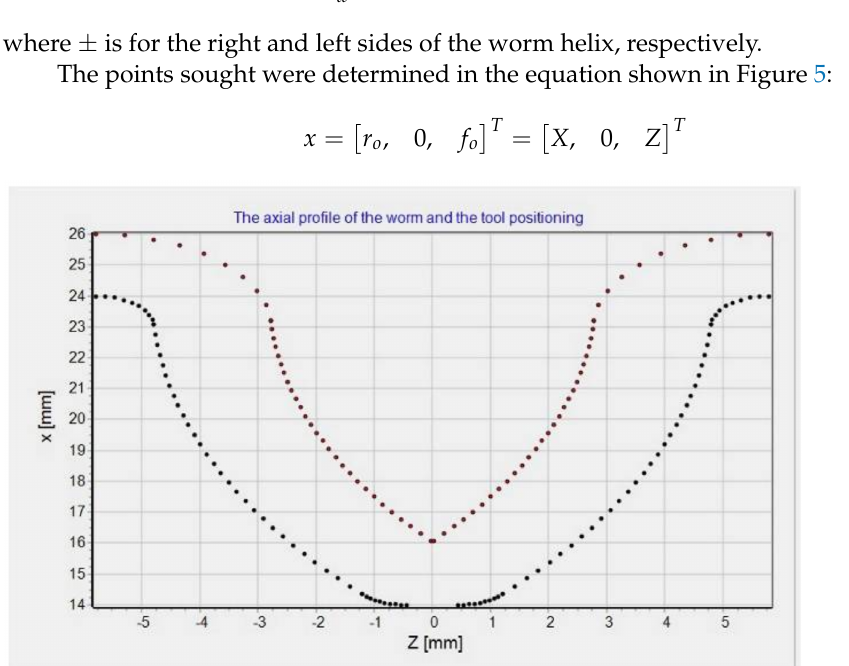
Figure 5. Authors’ program window: the points of the successive positions of the tool center, and the points of its contact with the axial contour of the worm with the following tool positioning parameters: module: m = 5; outer diameter: d 1 = 48 (mm); k = 1 number of threads; number of passes = 50; worm axial profile radius: ρ = 15 (mm); milling cutter radius: ρ f = 2